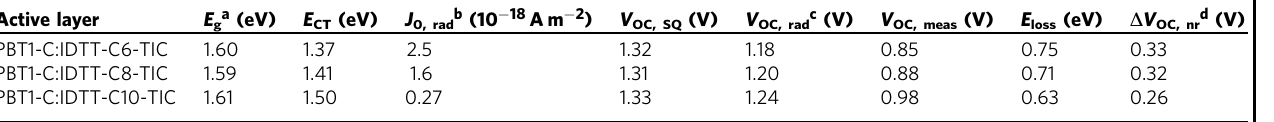
Table 2 Measured and calculated parameters to quantify voltage losses. Active layer